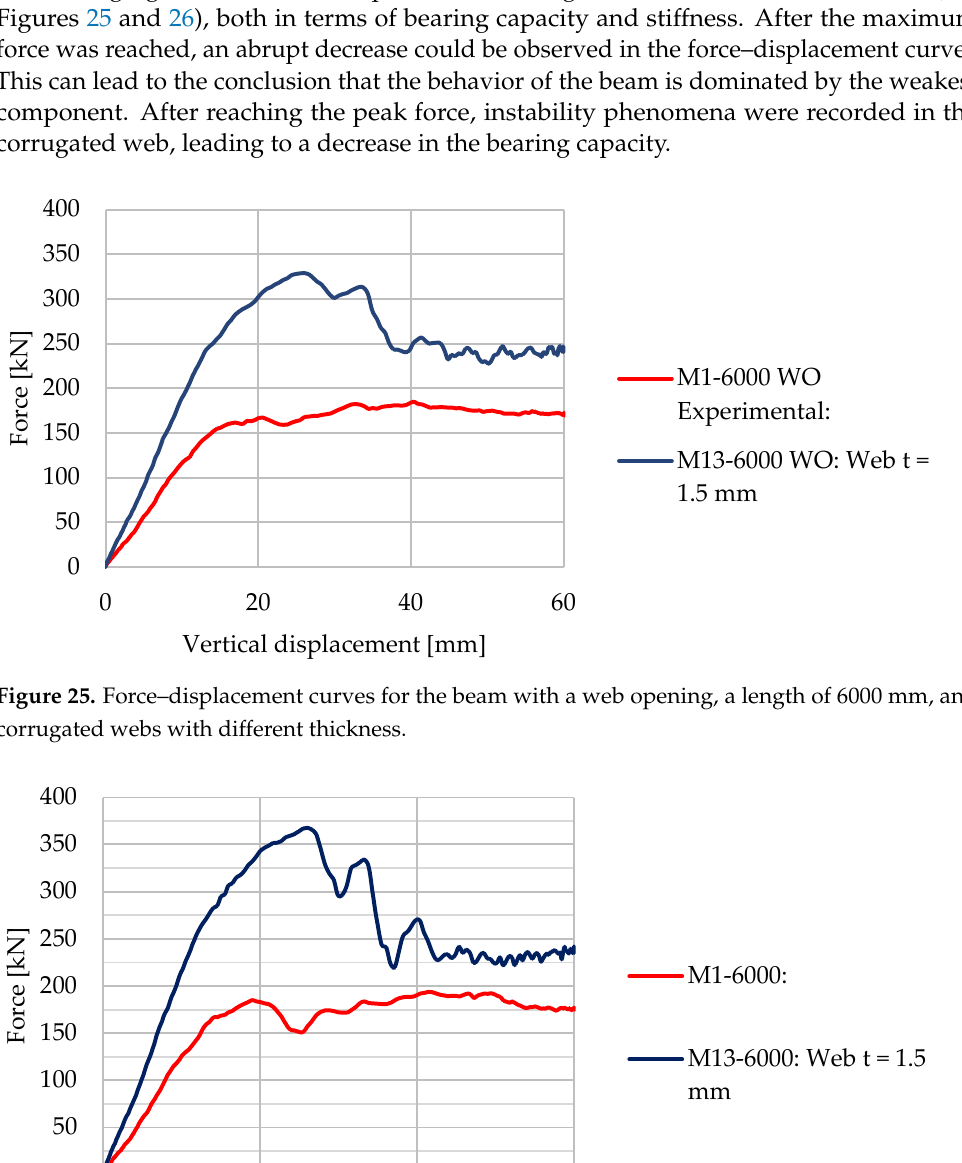
( c ) Figure 27. Comparison of failure modes in the final stage of loading for the beam with a web open- ing and a length of 6000 mm: ( a ) instability phenomena under the load application points for M1- 6000 WO, i.e., the beam with the corrugated web thickness of 1.00 mm; ( b ) no instabilities were recorded under the load application points for M13-6000 WO, i.e., the beam with the corrugated web thickness of 1.50 mm; ( c ) failure of the M13-6000 WO beam was due to local buckling of the shear panels coupled with the distortion of the corrugations connected to the lower flange. 4.5. Summary of the Main Parameters The main parameters which influence the behavior of the built-up cold-formed steel beam were found to be the height of the beam, the section and thickness of the flanges, the thickness and length of the shear panels, and the thickness of the corrugated web. The main parameters are presented in terms of maximum force in Figures 28–30 for each beam.